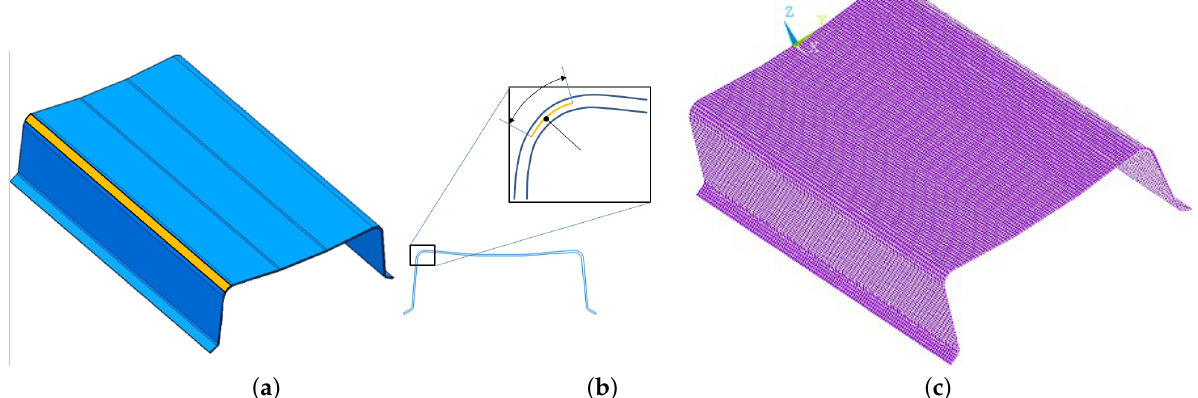
Figure 2. ( a ) Sample composite component with artificial delamination, ( b ) the position of delamination, ( c ) FEM model for data